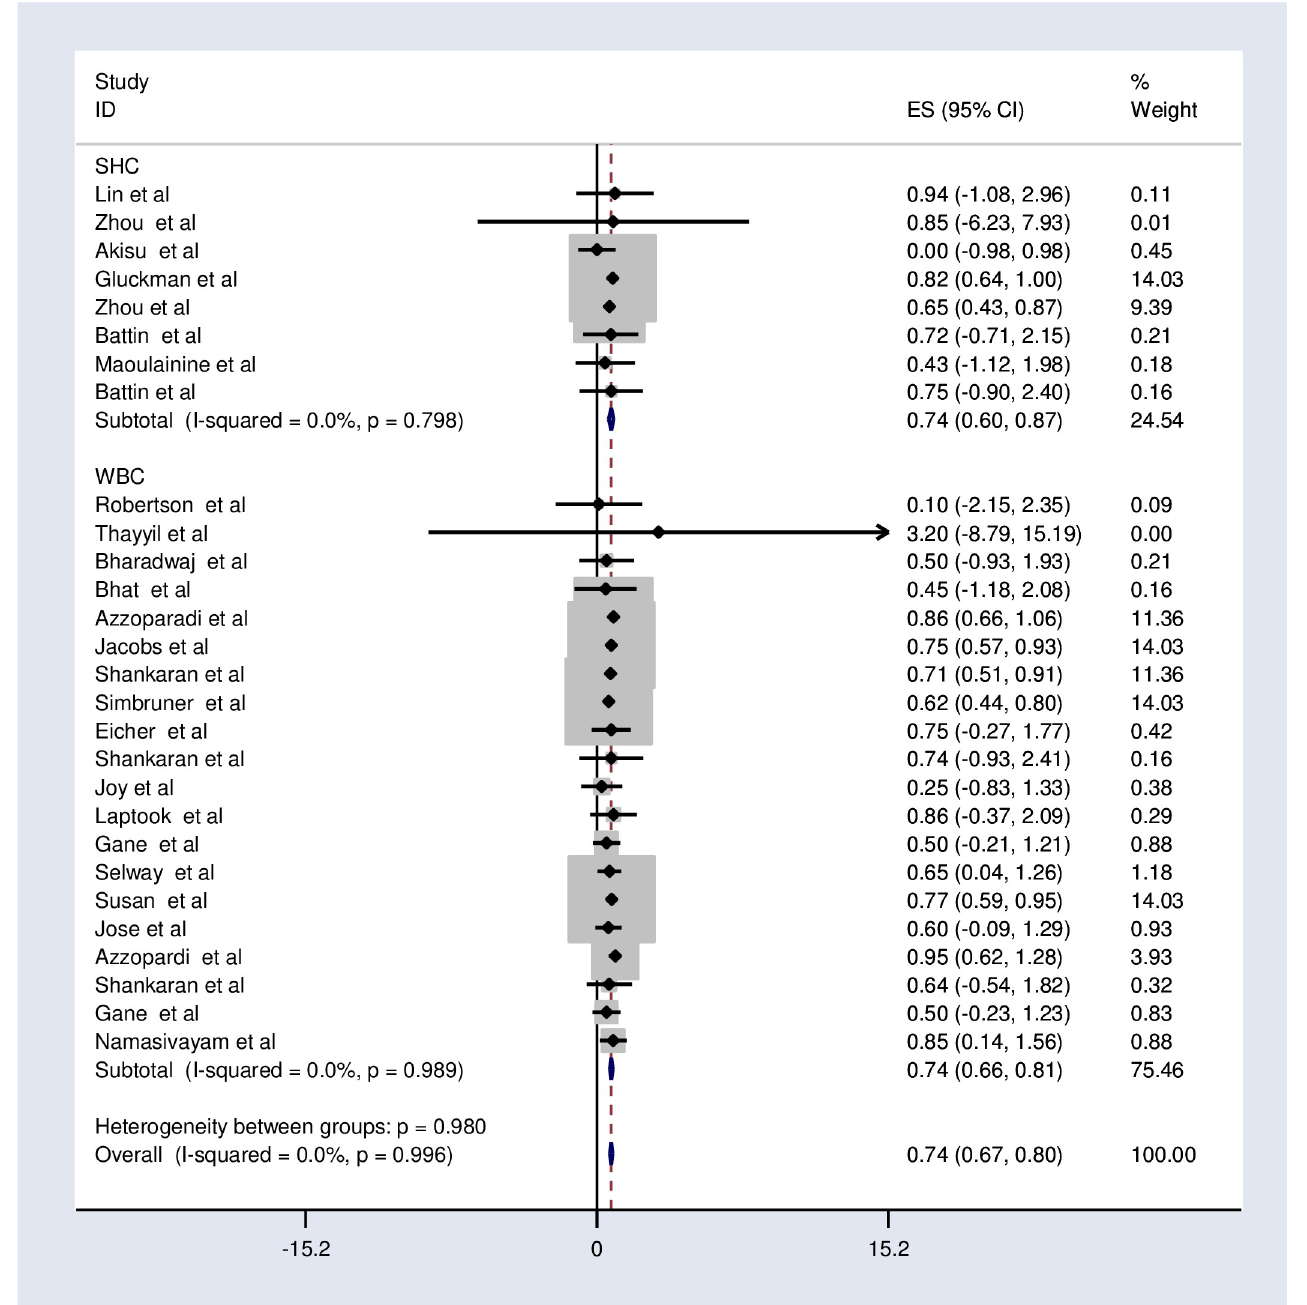
Fig 4. Subgroup analysis by the method of cooling effects of therapeutic hypothermia on death among asphyxiated neonates with hypoxic-ischemic encephalopathy.